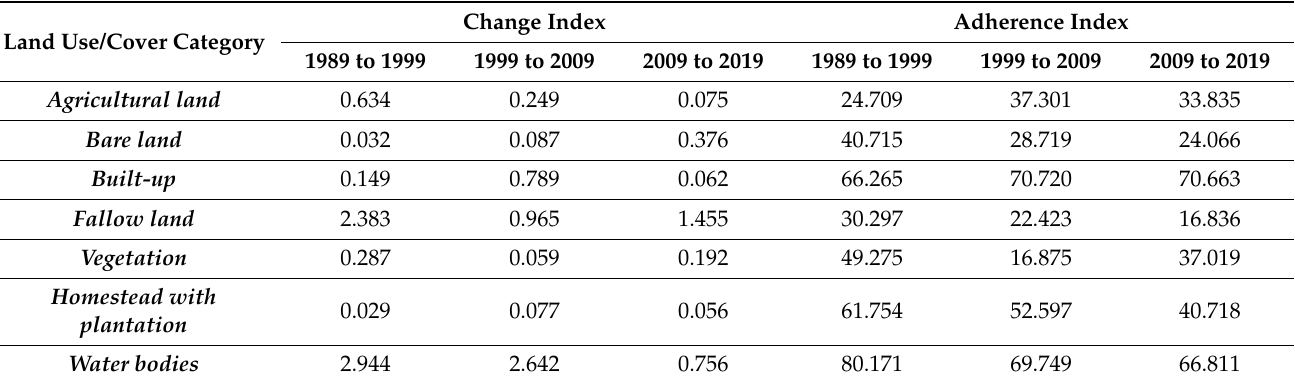
Table 18. Land use and land cover change index and adherence index.